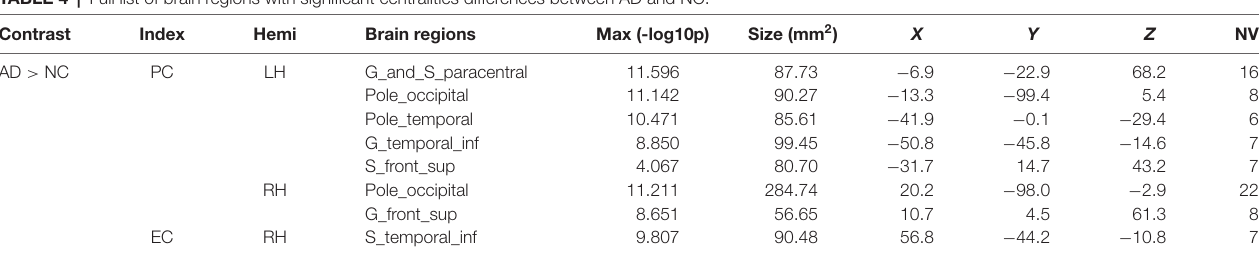
TABLE 4 | Full list of brain regions with significant centralities differences between AD and NC.